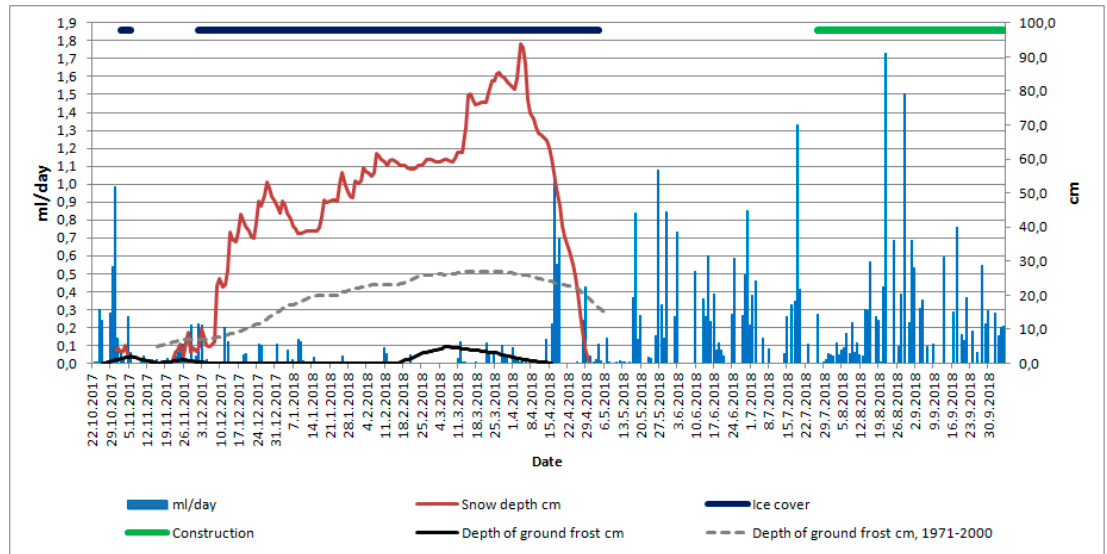
Figure 4. Daily sedimentation flux rate of Savilahti Bay from 22 October 2017 to 6 October 2018. Bar diagram shows sediment flux rate in mL/day, line diagram shows snow depth in cm (red line), ground frost depth in cm (black line), and monthly averaged ground frost depth from 1971 to 2000 in cm (dotted gray line). Note that ground frost in cm means depth below the ground surface. Bold lines on top of diagrams show ice cover (dark blue) and construction (green) events during the investigation period.